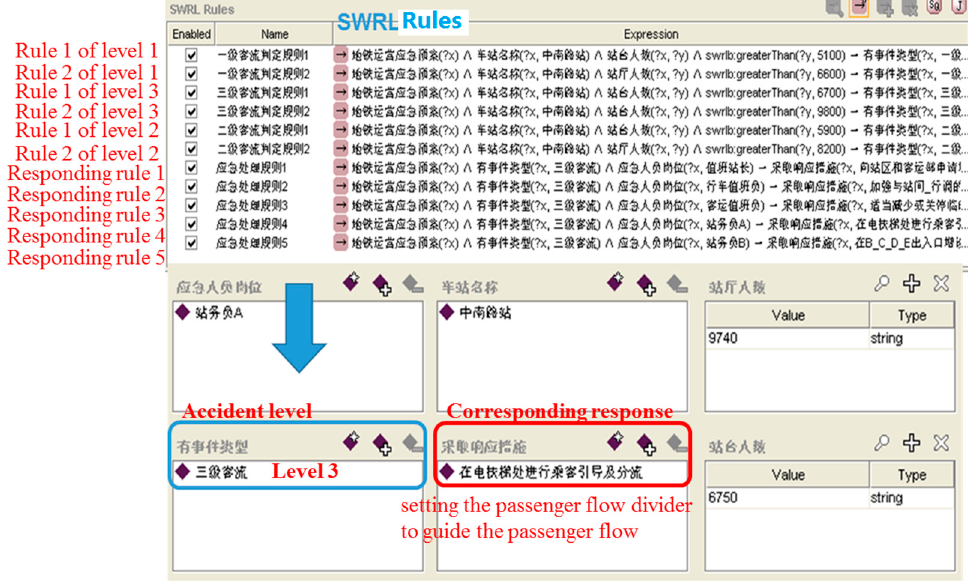
Figure 12. The decision-making result as shown in the interface of Protégé.